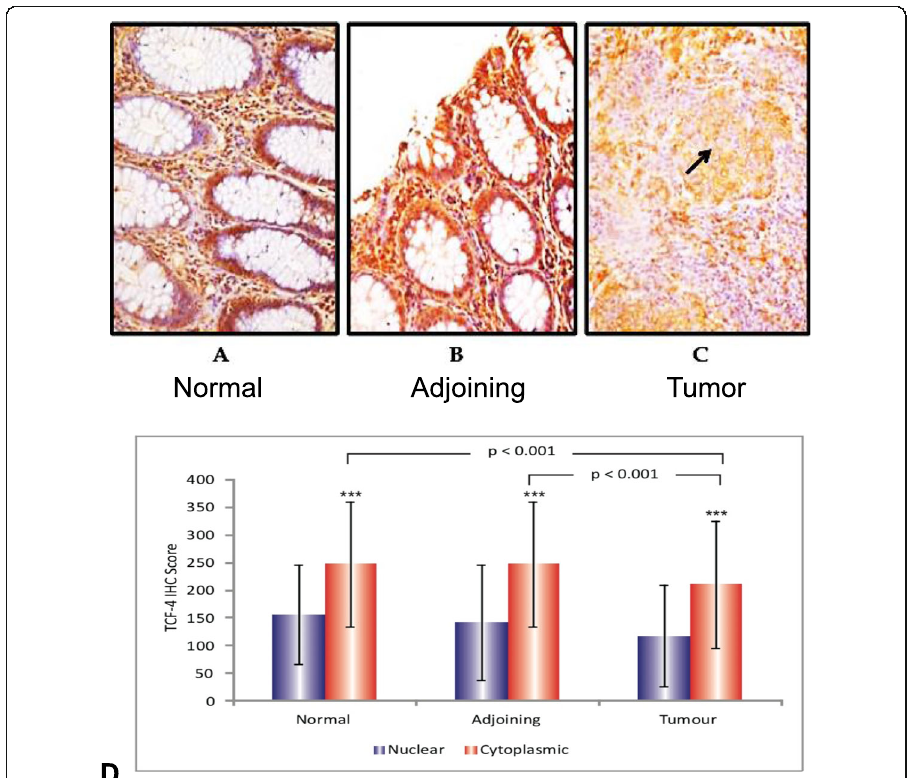
Fig. 3 Analysis of TCF-4 protein expression by immunohistochemistry. a, b & c show immunohistochemical analysis of TCF-4 protein in normal ( a ), adjoining ( b ) and tumor tissues ( c ) from CRC Patients. Magnifications